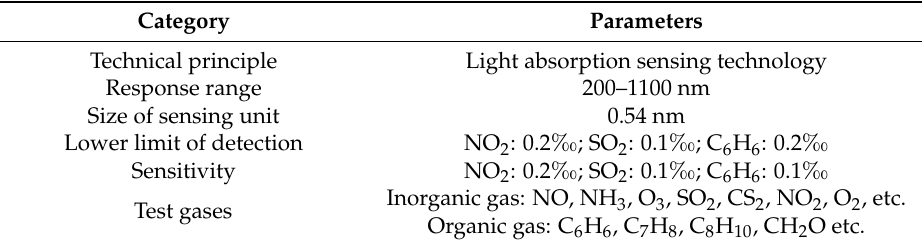
Table 1. Technical parameters of light absorption gas detection system.